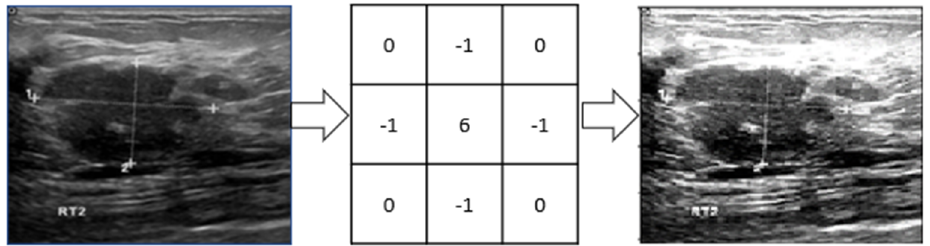
Figure 4. A 3 × 3 image sharpening kernel has been applied to sharpen images.